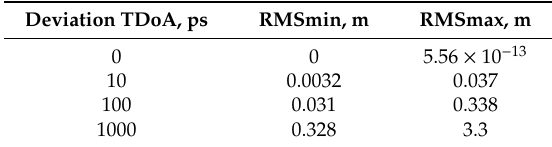
Table 2. RMS min and RMS max for analytical method (LPS).